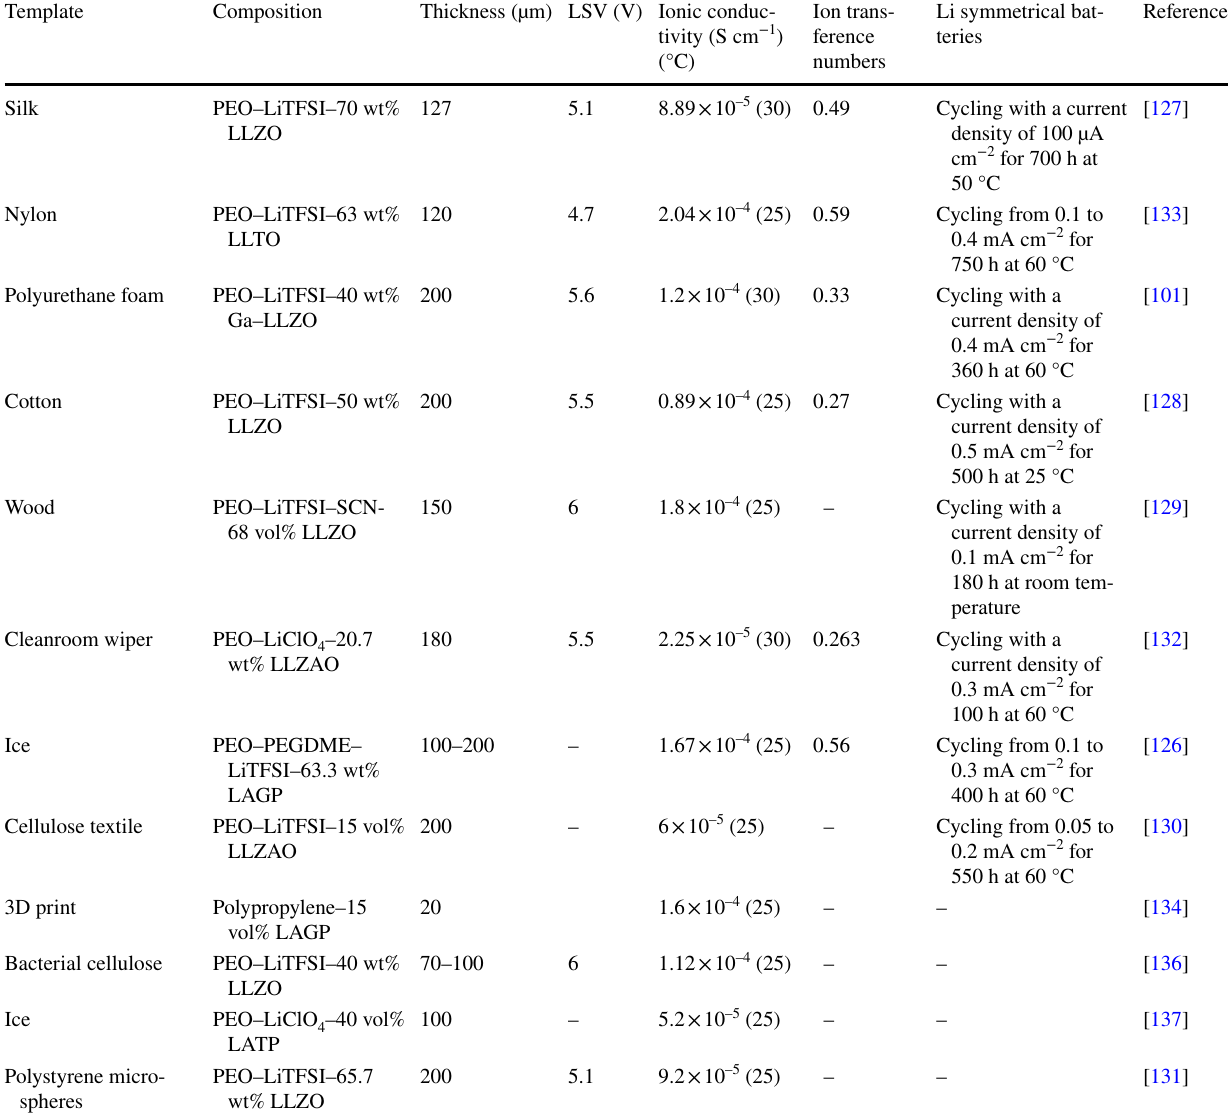
Table 1 Performance comparison of electrolytes with different templates